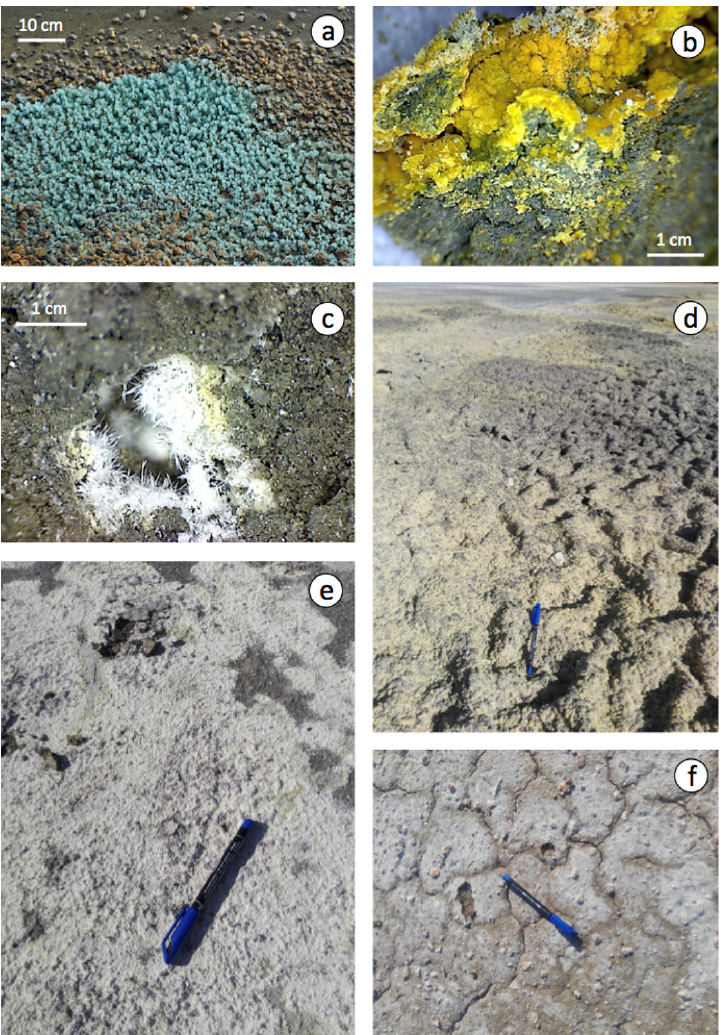
Figure 6. Efflorescent blooms of sulphate minerals on the surface of the pyrite wastes: ( a ) greenish- blue crystals of melanterite; ( b ) fine-grained yellow crust of copiapite; ( c ) white hairy halotrichite; ( d – e ) yellow to white encrustations of mixtures of soluble sulphate salts covering the floodplain; and ( f ) crystallization of efflorescent halite on soil surface with desiccation cracks (distal zone).